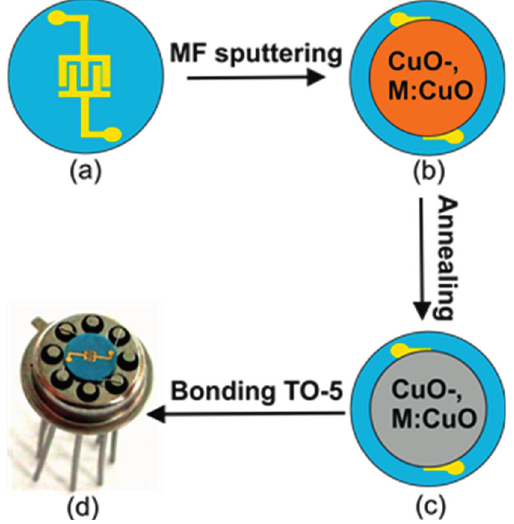
Figure 2. Schematic view of fabrication of gas sensors: ( a ) sensor substrate fabricated in low temperature cofired ceramic (LTCC) technology with interdigitated Au electrodes on the top; ( b ) CuO- and M:CuO-based thin films, obtained by MF sputtering deposition (the deposition parameters are in the text); ( c ) CuO- and M:CuO-based sensors after annealing (400 °C/4 h in air); ( d ) sensor mounted to the TO-5